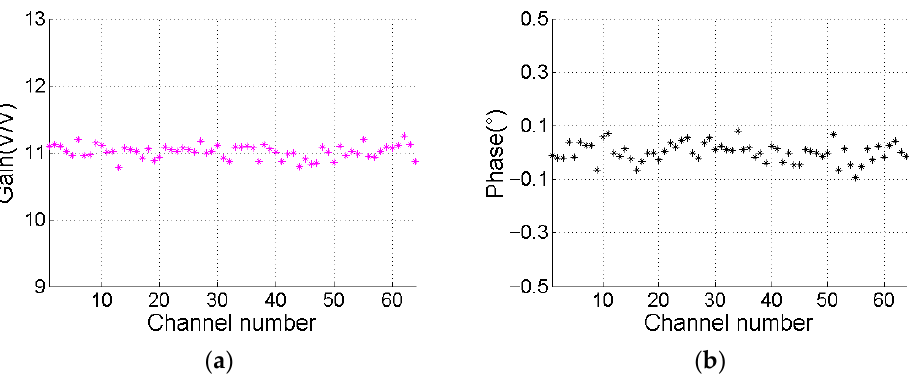
Figure 25. The results of consistency test ( a ) Amplitude consistency; ( b ) Phase consistency.